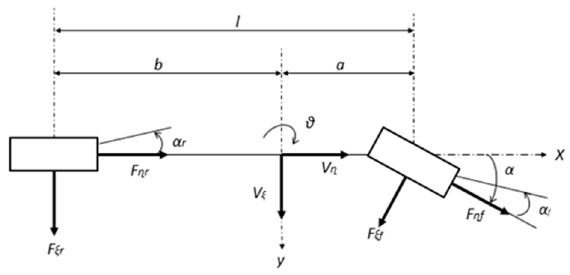
Figure 1. Illustration of single tracked bicycle model of vehicle handling characteristics as derived by [15].